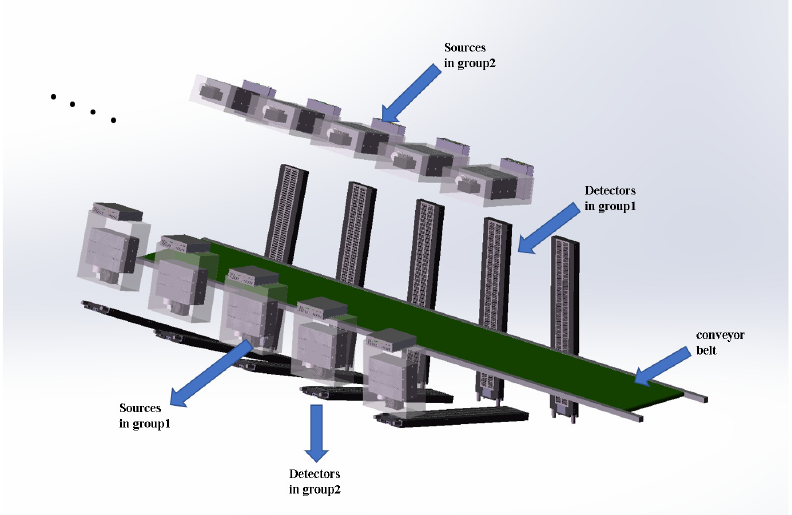
Figure 3. Scenograph of the system. From 0 ◦ to 101.5 ◦ , X-ray sources and detectors are arranged every 3.5 ◦ , and a total of 30 pairs are arranged, forming the first group. From 105 ◦ to 206.5 ◦ , other pairs of X-ray sources and detectors are arranged every 3.5 ◦ for a total of 30 pairs as well, forming a second group, and the two groups add up to a total of 60 pairs of X-ray sources and detectors; the overall view and side view of the system is shown in Figure 4.